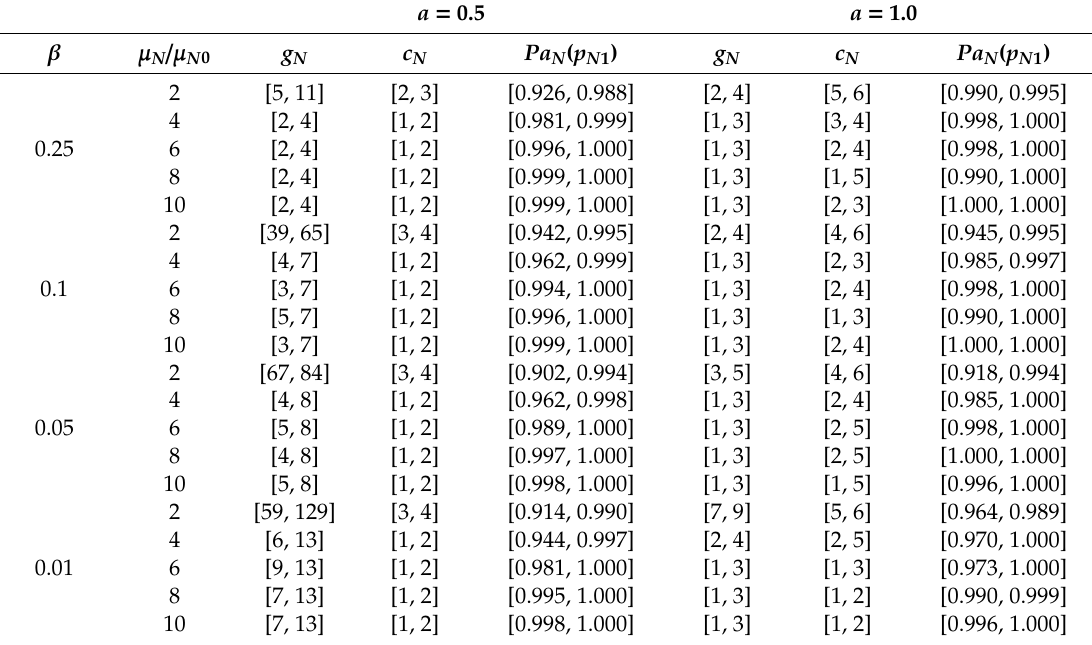
Table 2. Optimal parameters of the proposed GASP under neutrosophic statistics when r N = [10, 12] and δ N = [1.9,